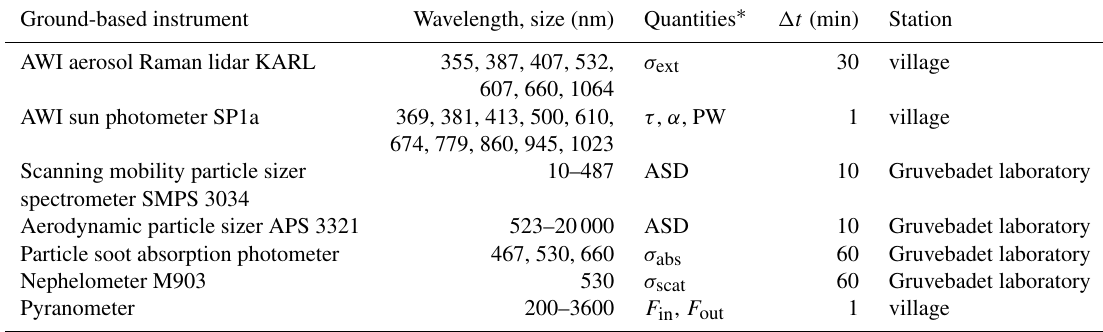
Table 1. Description of the instruments installed at Ny-Ålesund, used as input data for the atmospheric RTM. Ground-based